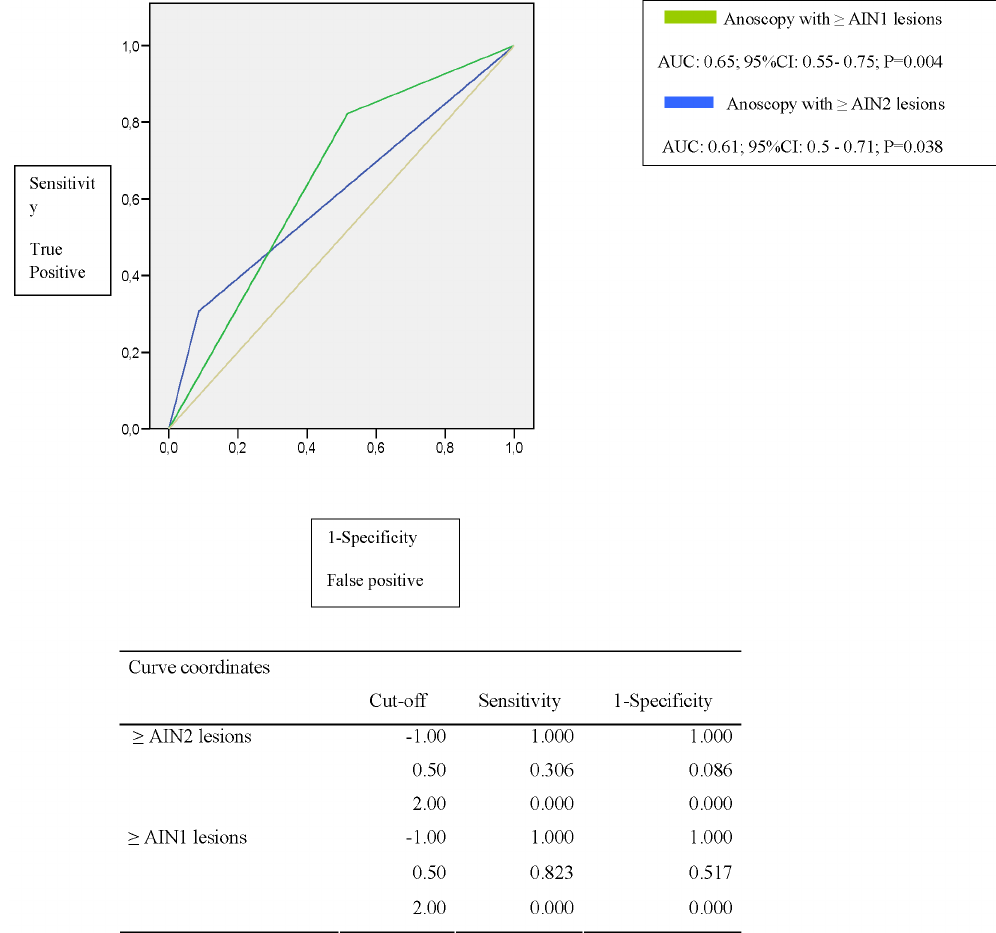
Figure 2. ROC curve of normal cytology vs . $ AIN 1 and $ AIN 2 lesions.